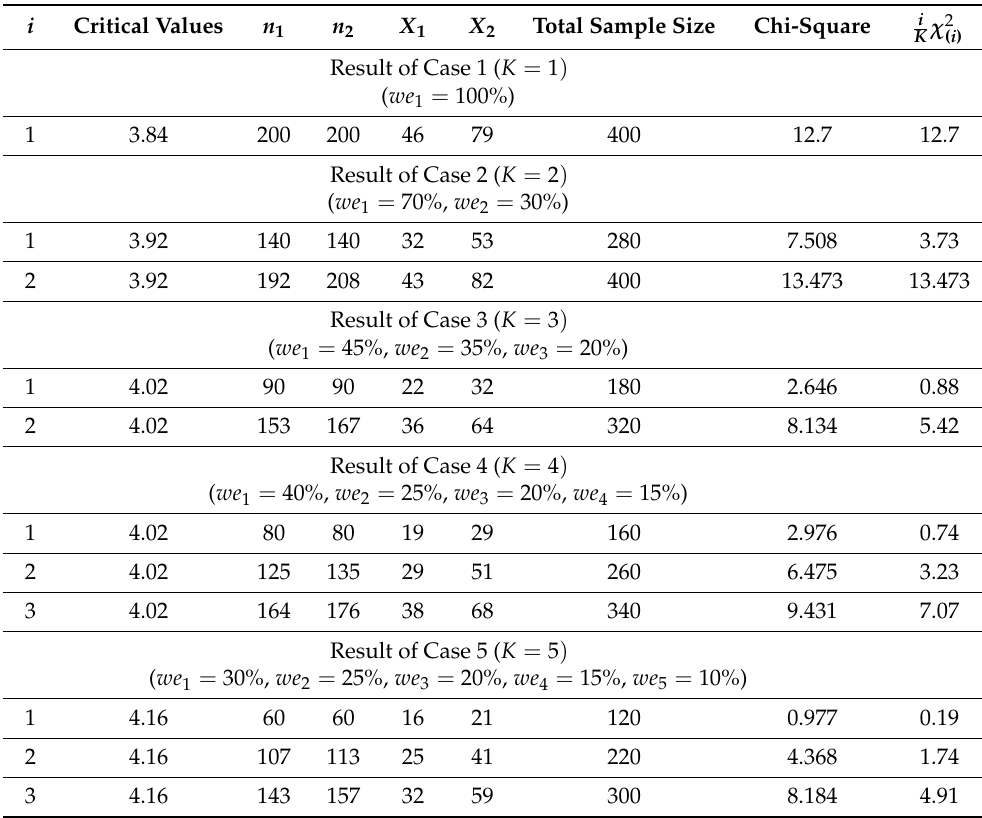
Table 10. The results of the OWMP for simulated